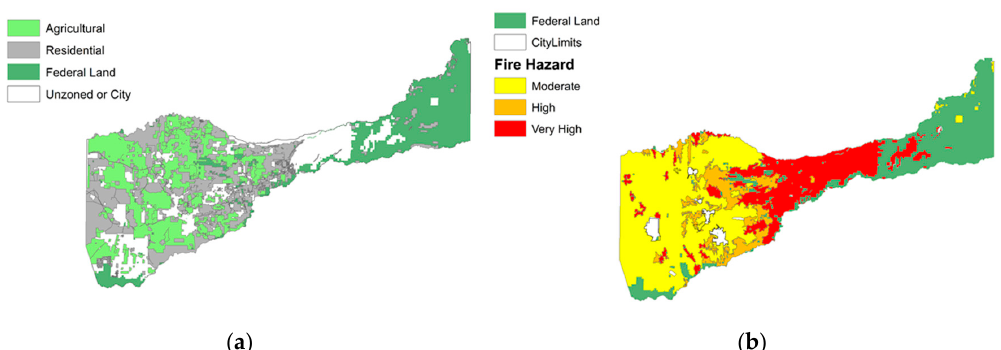
Figure 4. ( a ) Land use zones established by the Amador County General Plan Zoning Ordinance. ( b ) Overlay of wildfire hazard zones developed by CAL FIRE for use by Amador County along with areas that allow residential construction.